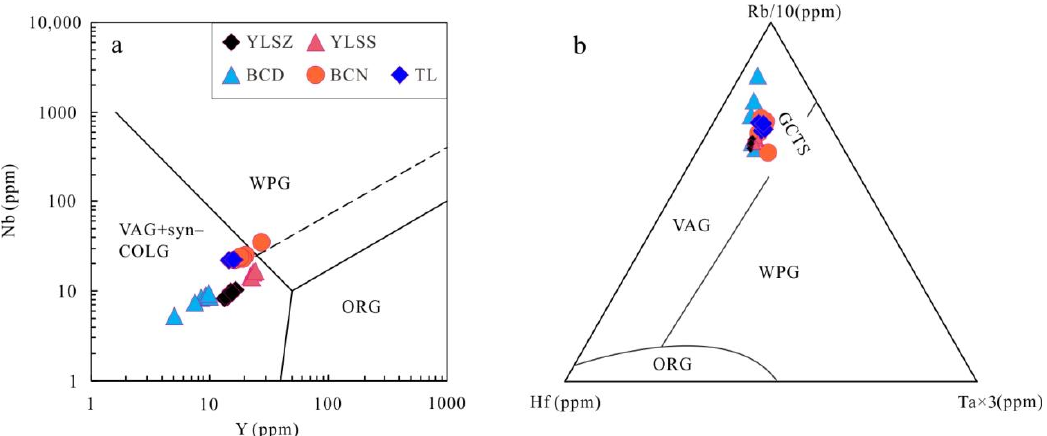
Figure 11. Y versus Nb ( a ) [148] and Rb–Hf–Ta ( b ) [153] diagrams for the Yilashan and Amdo granitoids in the Nagqu area. WPG: within-plate granites; VAG: volcanic arc granites; syn–COLG: syn-collisional granites; ORG: ocean-ridge granites; GCTS: granites from a collisional tectonic setting.